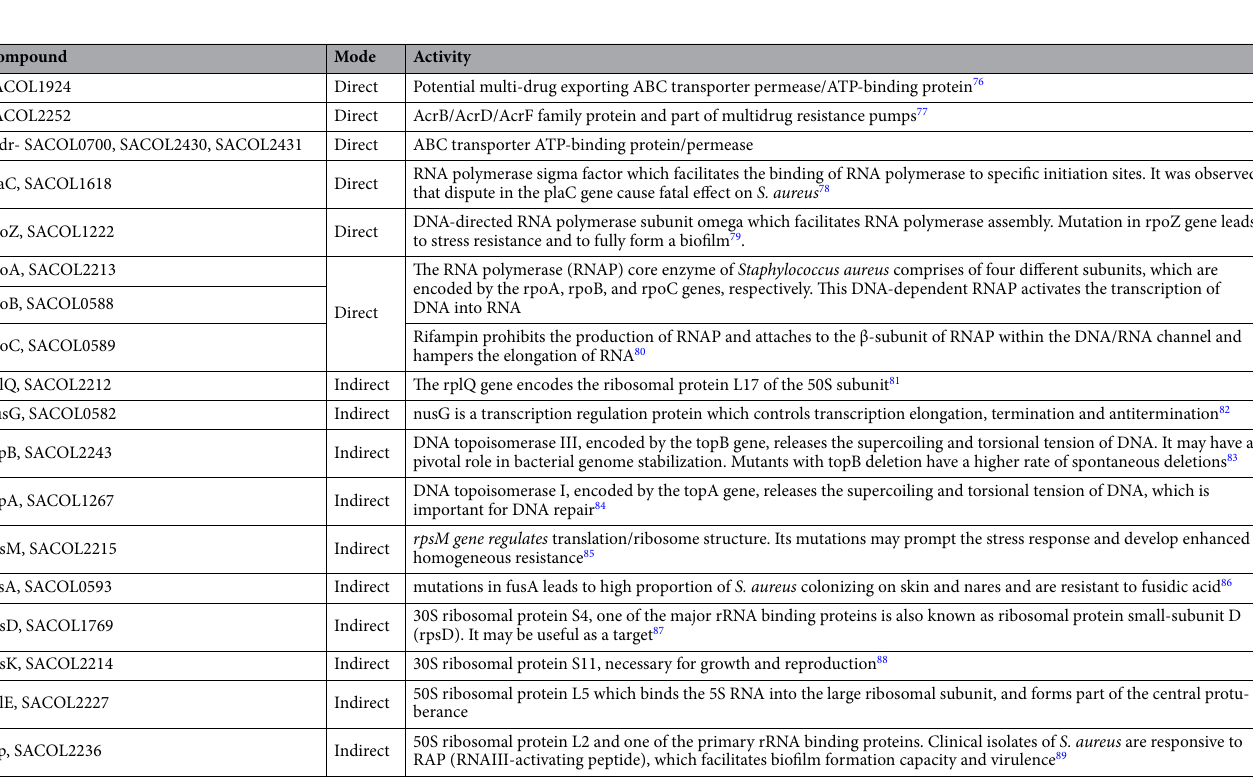
Table 5. Effect of antituberculosis drug Rifampicin (RF) on